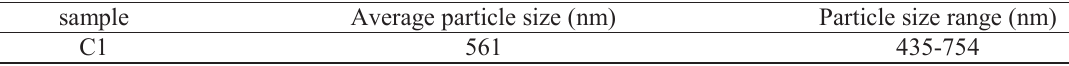
Data obtained from PSA technique for C1 catalyst.